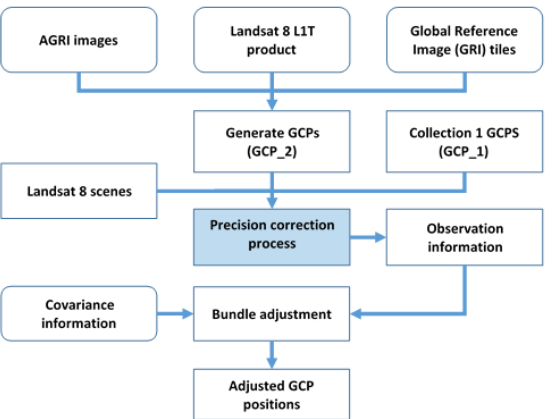
Figure 3. Schematic flow of how GRI- and Landsat-8-derived Ground Control Points (GCPs) are used in the bundle adjustment techniques. The triangulation-based bundle adjustment provides correction estimates for the spacecraft information (ephemeris, velocity, attitude, attitude rate) along with position updates for the GCPs, but we are interested only in the updates to the GCP positions.